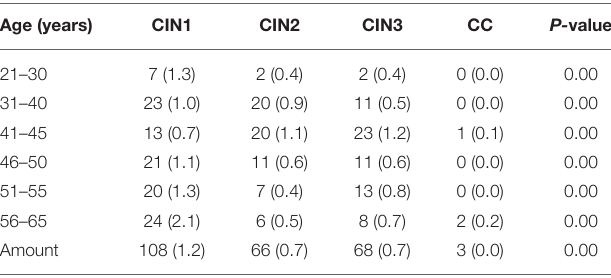
TABLE 6 | Rate of detection of histological abnormalities according to age group, N